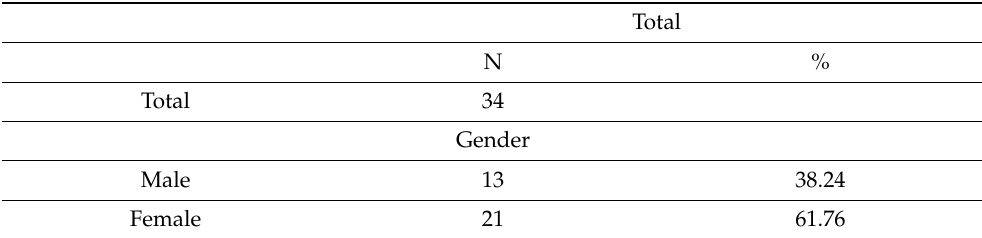
Table 1. Clinical pathological characteristics of 34 selected